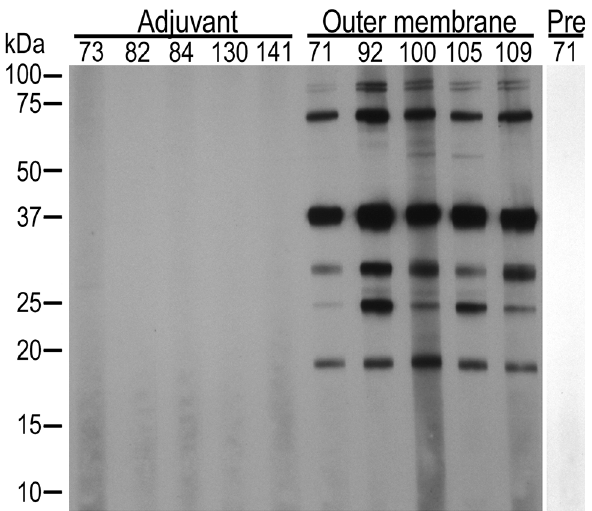
Fig 1. Western blot demonstrating a specific antibody response to native A . marginale proteins in vaccinates. A . marginale -infected erythrocytes loaded at 1x 10 8 infected red blood cells per well are used as antigen. Outer membrane vaccinates (Outer membrane) have antibody directed against multiple antigens, as expected. No anti- A . marginale antibodies are detected in the group that received adjuvant alone (Adjuvant) or prior to immunization (Pre), shown for animal 71. All western blots were done with a serum dilution of 1:100. Animal numbers are listed across the